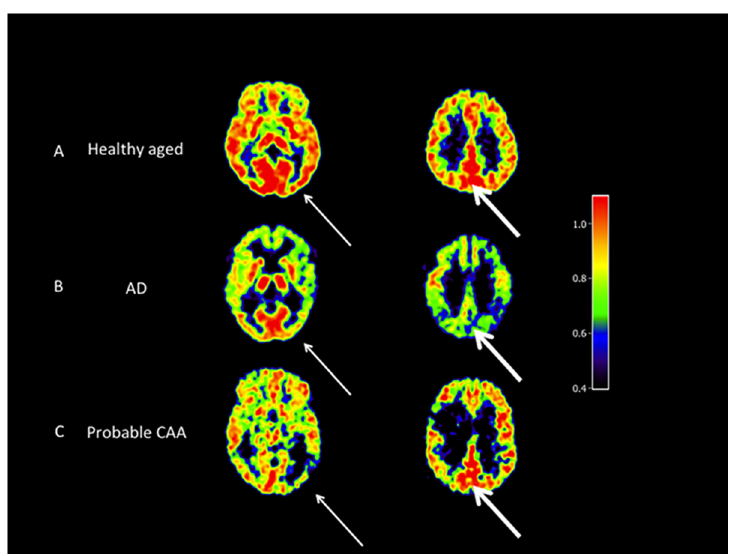
Fig 2. Representative early-phase PiB SUVR axial images (normalized to the subject ’ s vermis value) for the basal ganglia (left column) and centrum semiovale level (right column) from one subject each from the age-matched healthy controls (A), AD (B) and probable CAA-related sLICH groups (C). The thin arrows point to the occipital region, showing the typical low uptake in the CAA profile as compared to age-matched controls and AD. The bold arrows point to the posterior cingulate area showing reduced uptake in AD as compared to age-matched controls and CAA. SUVRs were obtained from early-phase 11 C-PiB-PET using the cerebellar vermis as reference ROI (see